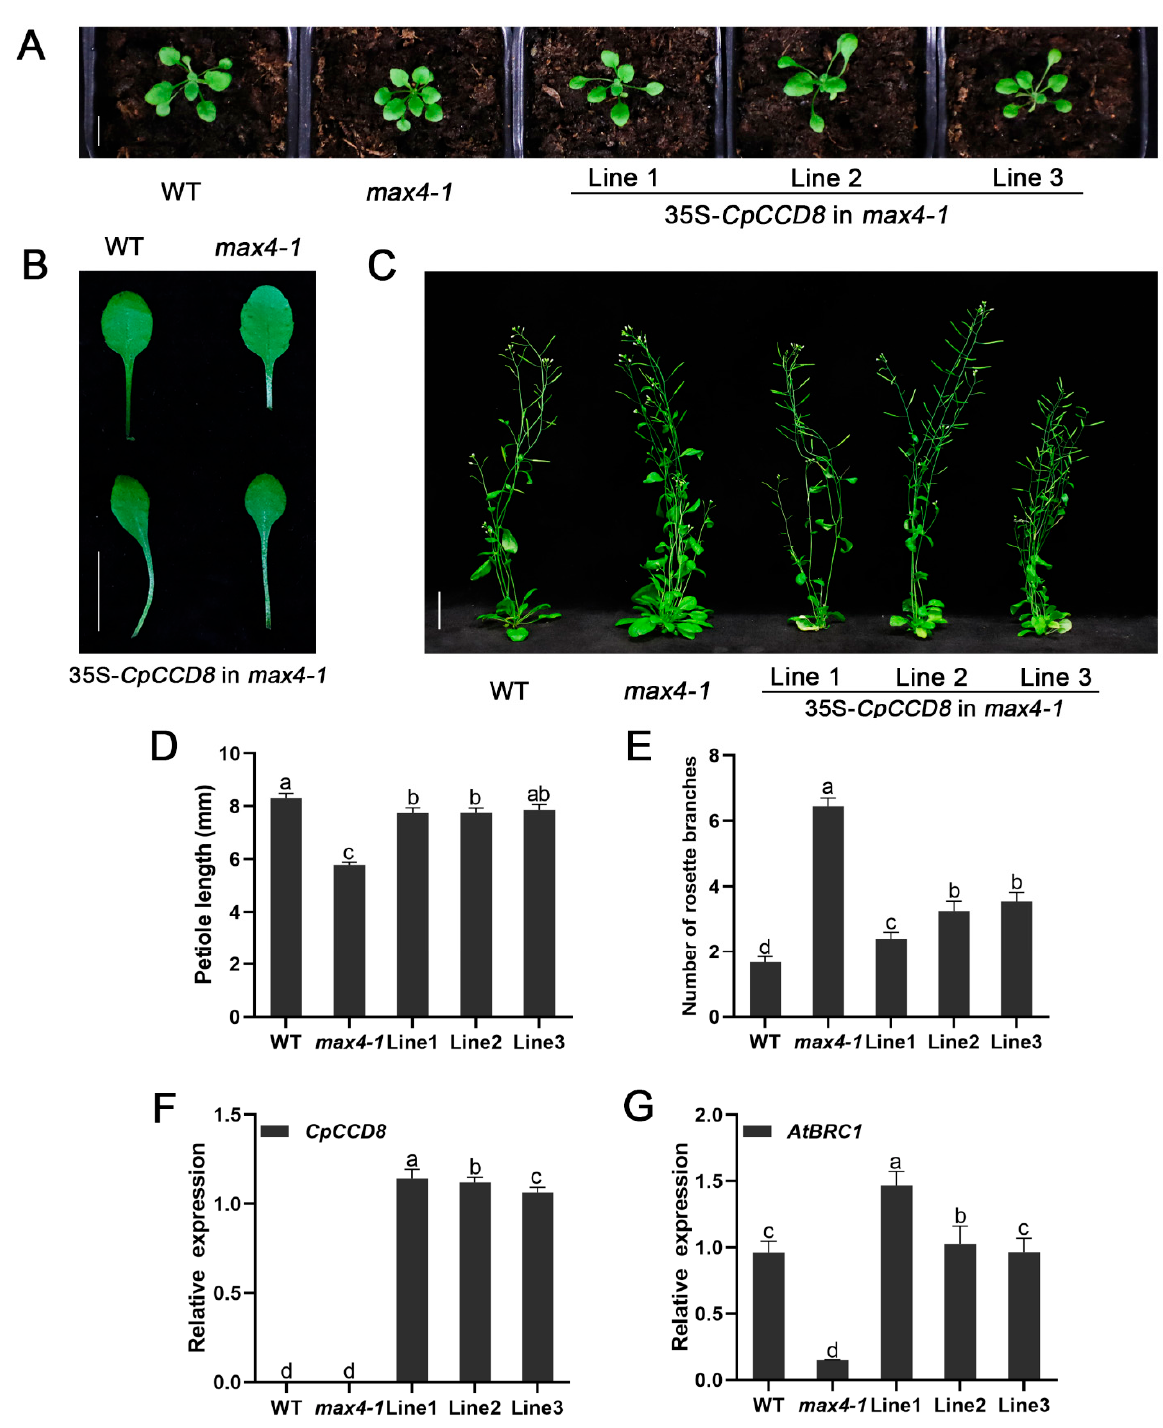
Figure 7. CpCCD8 overexpression restores the phenotype of the Arabidopsis branching mutant max4-1 . ( A ) Seedlings grown in soil for 2 weeks. ( B ) Petiole phenotype of WT, max4-1 and restored lines 1–3 grown in soil for 2 weeks. ( C ) Branching phenotype of WT, max4-1 and restored lines 1–3 at 35 d after transplant. In ( A – C ), scale bars = 5 mm. ( D ) Petiole length of WT, max4-1 and restored lines 1–3 grown for 2 weeks. ( E ) Number of rosette branches in WT, max4-1 mutant and CpCCD8 restored lines 1–3. Data represent mean ± SE ( n = 12–46). ( F , G ) Expression levels of CpCCD8 and AtBRC1 in WT, max4-1 mutant and CpCCD8 restored lines 1–3 (data represent mean ± SD of three biological replicates). The leaves and axillary buds of WT and complementation lines were collected used for qRT-PCR analysis at 35 d after transplant. Different lowercase (a–d,ab) above the bars indicates significant differences ( p < 0.05).